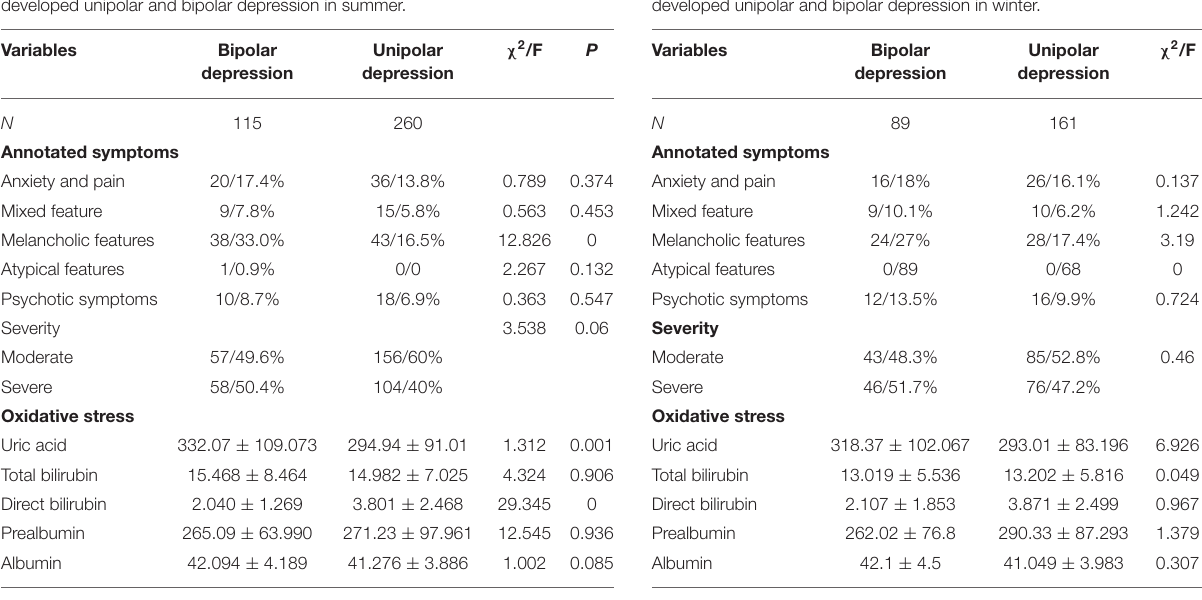
TABLE 5 | Symptoms and oxidative stress related indicators in patients who developed unipolar and bipolar depression in winter.